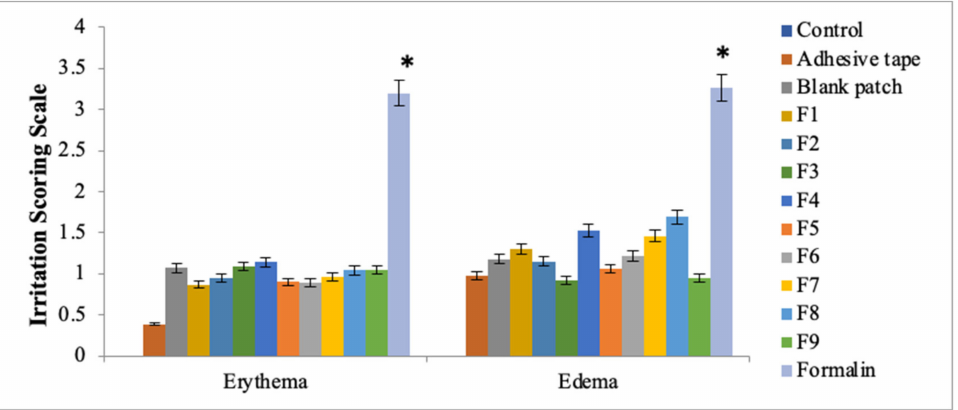
Figure 2. Skin irritation studies: erythema and edema. Data are expressed as mean ± SD; n = 3. One-way ANOVA followed by post hoc Tukey test; p < 0.05). (* p <